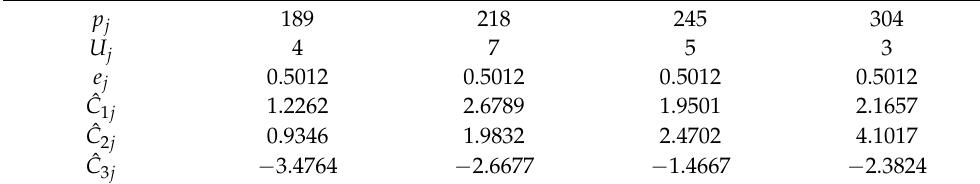
Table 5. Values of p j , e j , U j , ˆ C 1 j , ˆ C 2 j , ˆ C 3 j . p